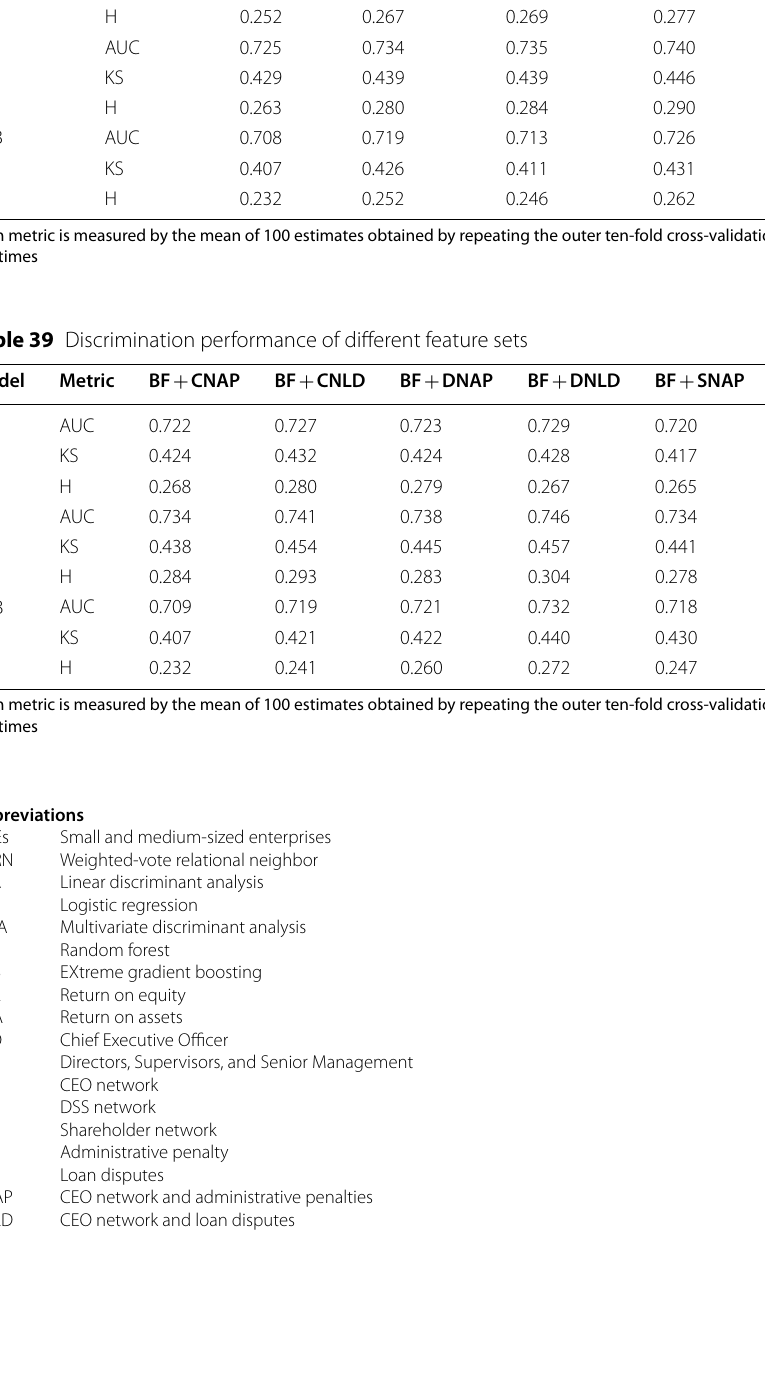
Table 38 Discrimination performance of different feature sets Model